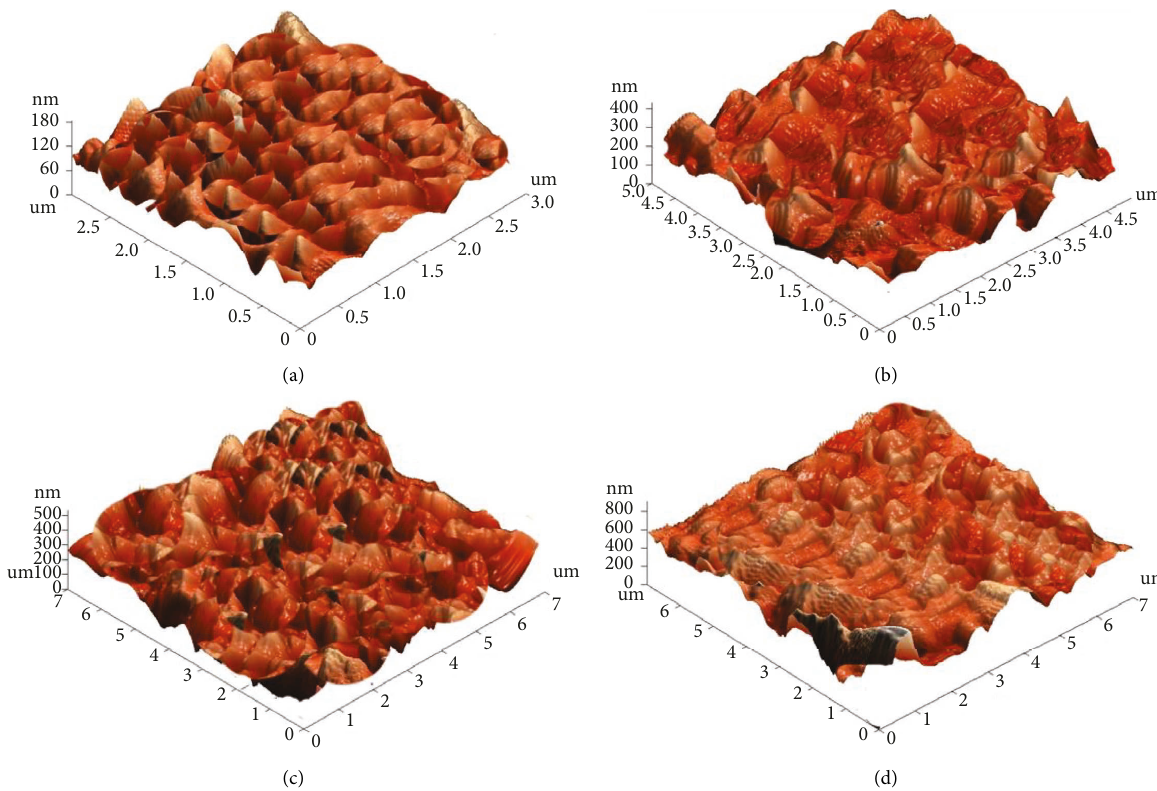
Figure 6: AFM studies of FeS 2 -coated solar cells (a) F1, (b) F2, (c) F3, and (d) F4.